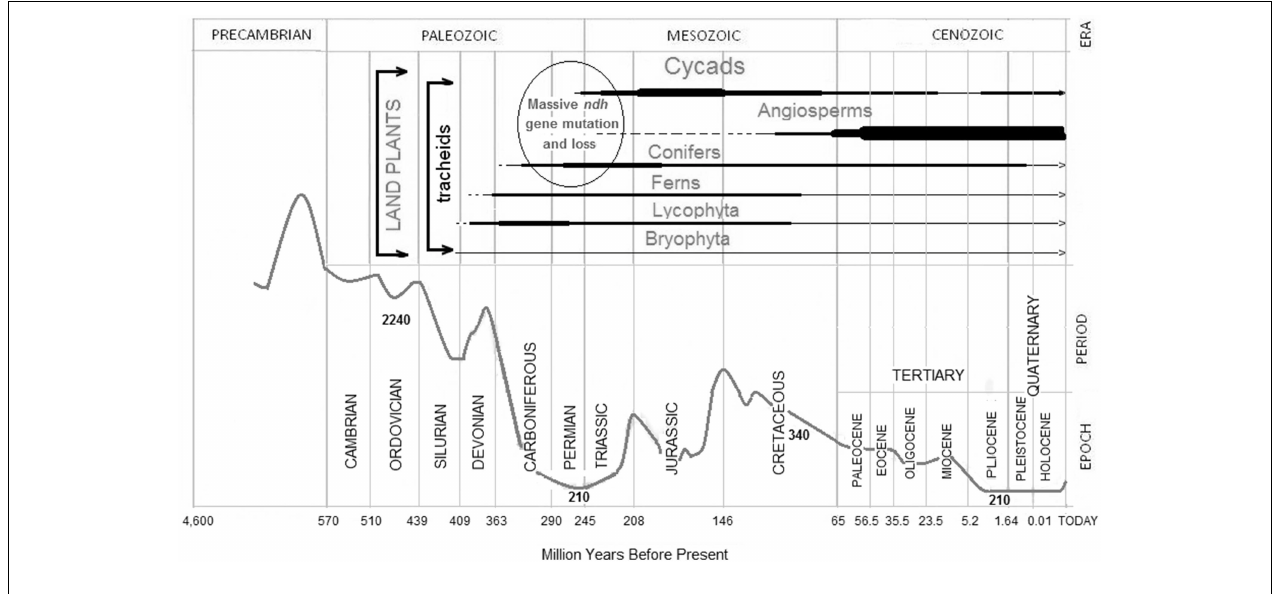
et al., 2009; Nagalingum et al., 2011 ). Representative CO 2 concentrations are indicated (in ppm) below the gray curve. The ellipsoid grouping Cycads, angiosperms, and Conifers in the Permian and Triassic indicates the period during which the proposed main massive ndh mutations occurred on the basis of data of plants lacking ndh genes or requiring ndh transcript editing. At present, there are limited data on the ndh genes of Ferns, Lycophyta, and Bryophyta, which were probably also affected by massive